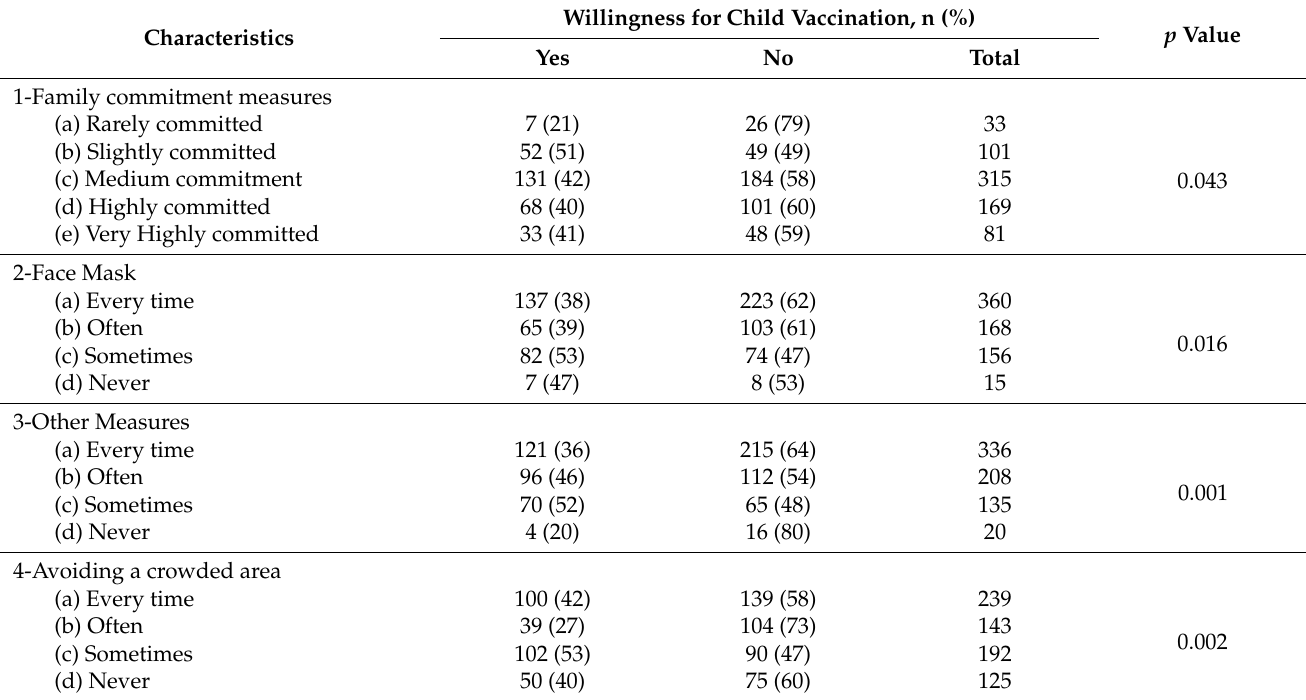
Table 6. Comparison of willingness for child vaccination with personal preventive measures.